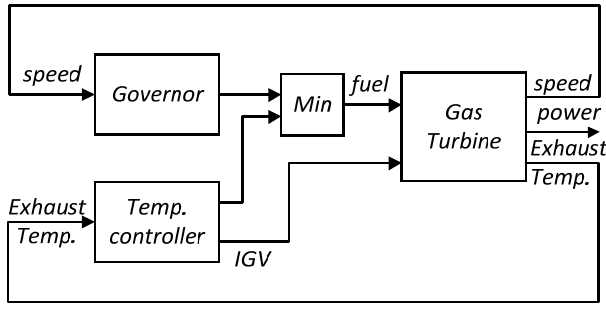
Figure 2. Simplified gas turbine control